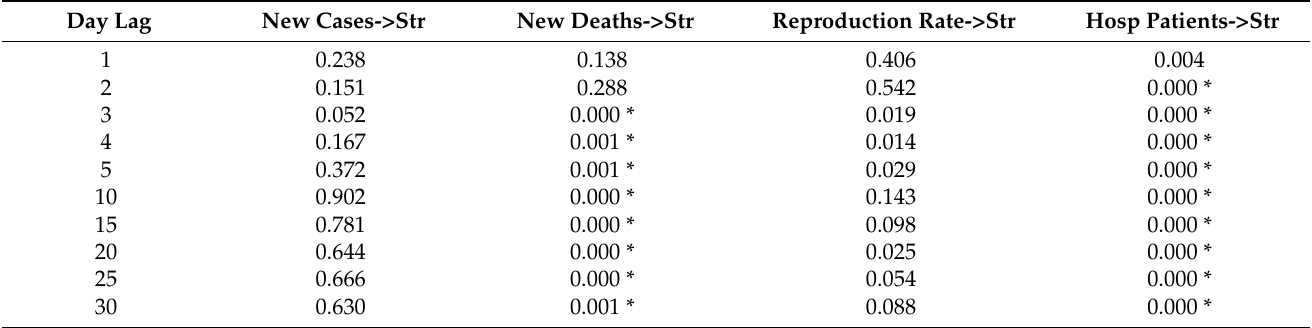
Table A11. Intensity variables, Granger-cause Stringency_index (Str), and p -values in day lags in Portugal.